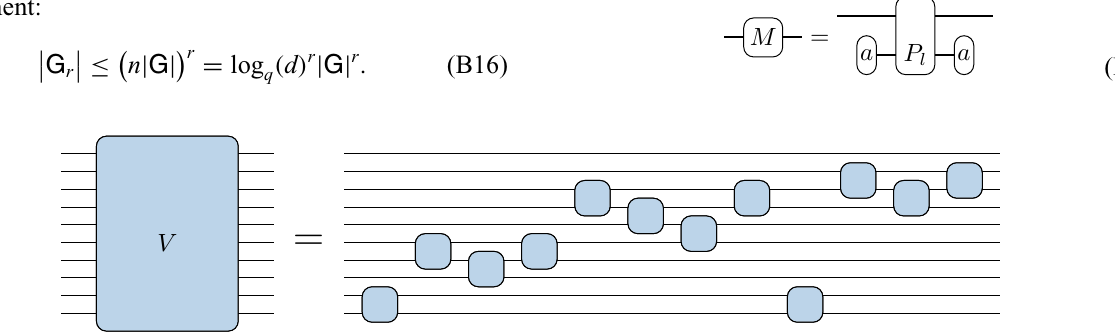
FIG. 4. Illustration of elementary gate decompositions. A unitary V on n = 10 qudits is comprised of 12 geometrically local 2-qudit gates at random positions, i.e., size ( V ) =